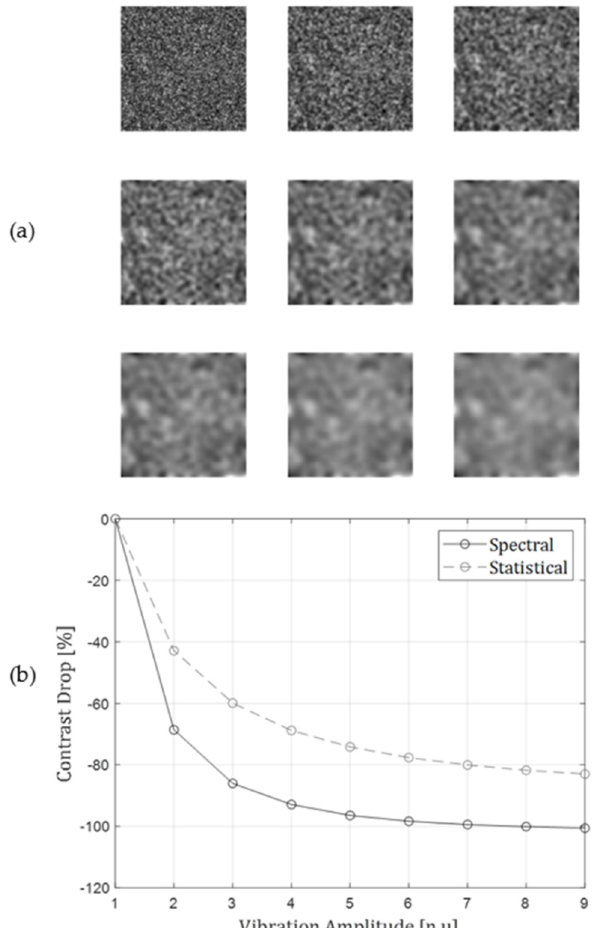
Figure 2. ( a ) A set of simulated speckle pattern in different contrast affecting scenarios. Each image represents a degrading contrast of the speckle pattern, due to heavier smoothing. ( b ) A comparison between contrast drop of traditional statistical calculation, and the suggested optical spectral estimation, for the corresponding images from ( a ).